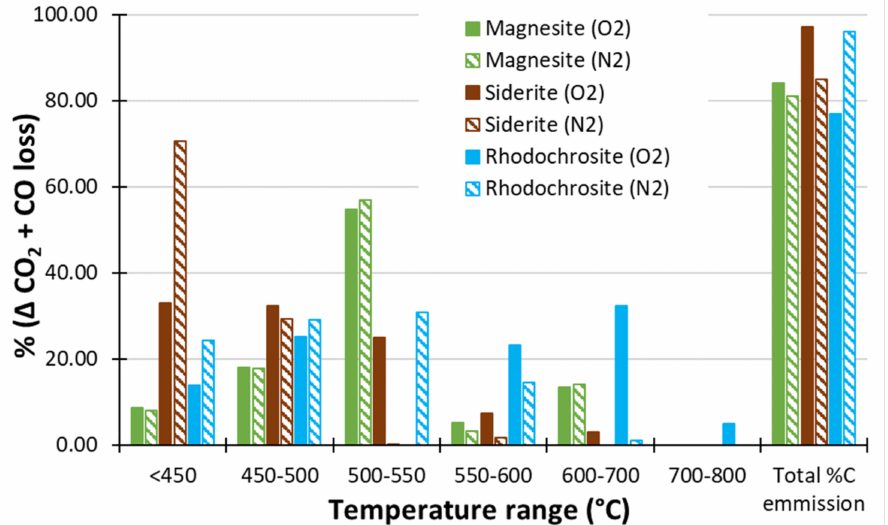
Figure 2. Decomposition behaviours of magnesite, rhodochrosite and siderite using N 2 and O 2 carrier gases. To show rhodochrosite on this graph, the data for <400 ◦ C are shown as <450 ◦ C, and the data for 500 − 600 ◦ C are shown as 550 − 600 ◦ C. The sum of the values for each mineral across the temperature ranges has been normalised to 100%. The total %C emission, as a % of the total C present, is also